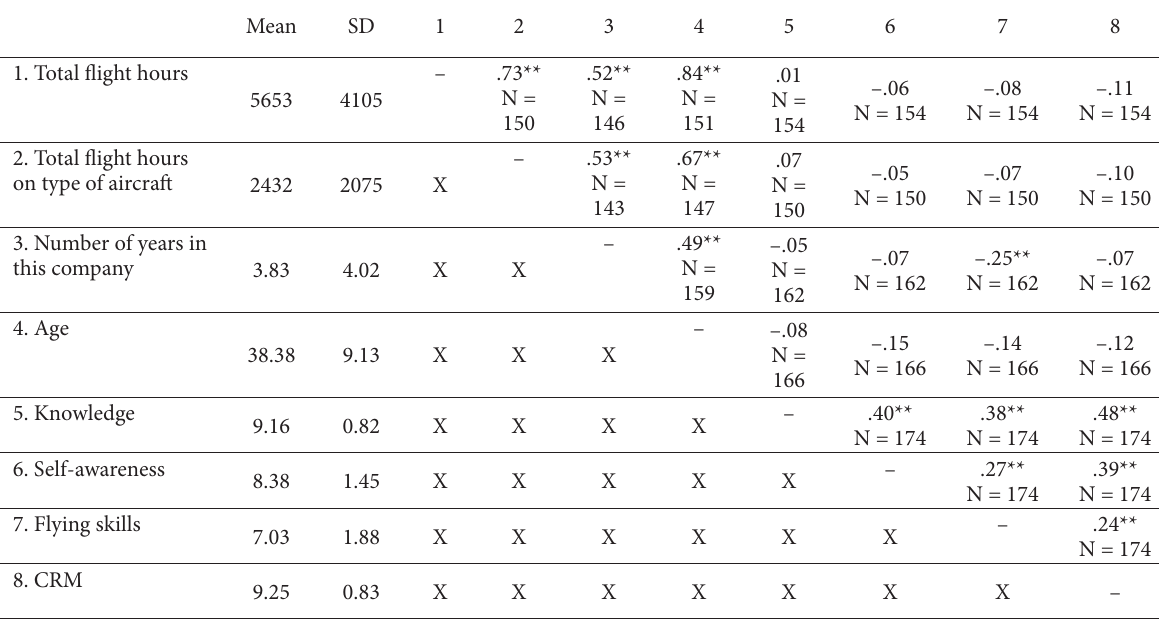
Table 2. Inter correlations between flight hours, number of years in the company, age and the four attitude scales (Principles